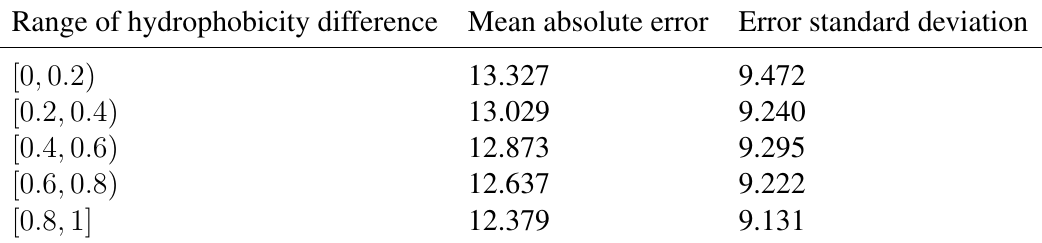
Table 5: Analysis of error according to the difference of hydrophobicities of amino acids whose distance is predicted, using proteins of Experiment 4.